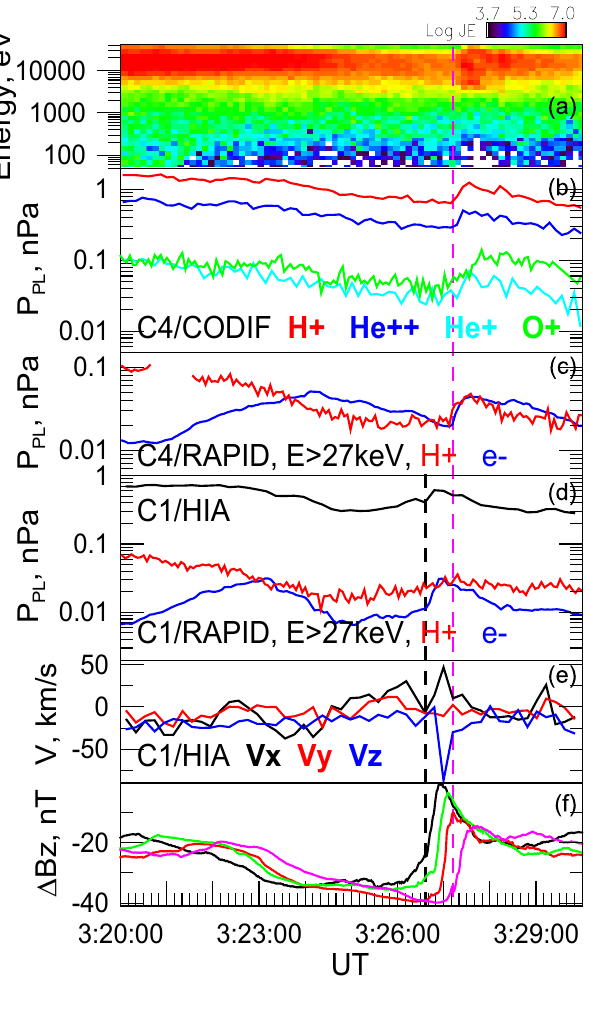
Fig. 8. Cluster 1 and 4 ion and energetic particle observations. Cluster 4: (a) CIS/CODIF H+ omnidirectional energy flux;